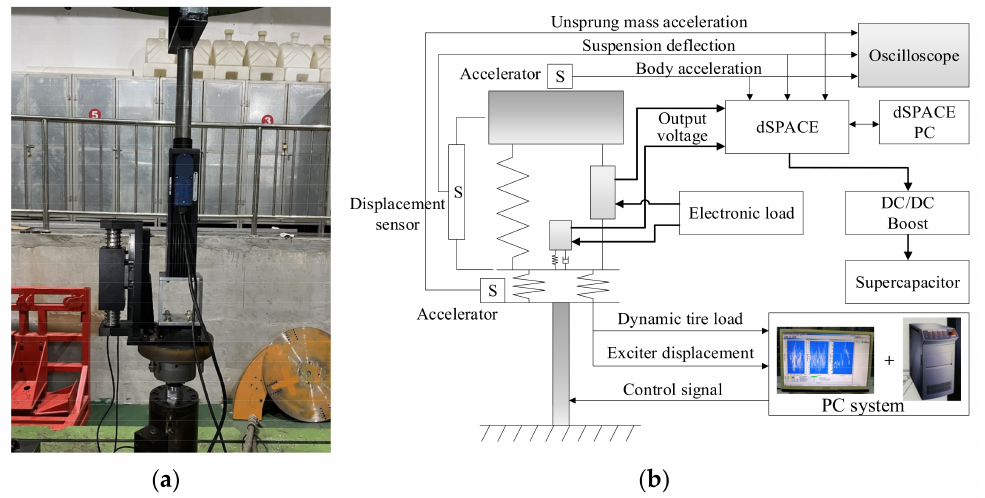
Figure 15. Test bench and system. ( a ) Test bench. ( b ) Test